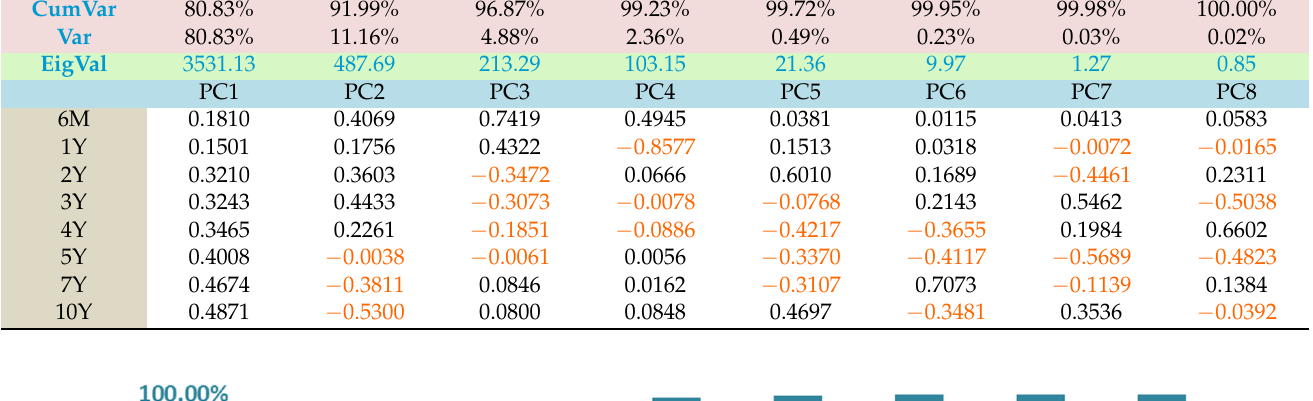
Table 1. Factor loadings , eigenvalues, and variances explained by principal components on 25 March 2022. Source: Bloomberg, own computation of PCs with the use of a VBA add-in developed by